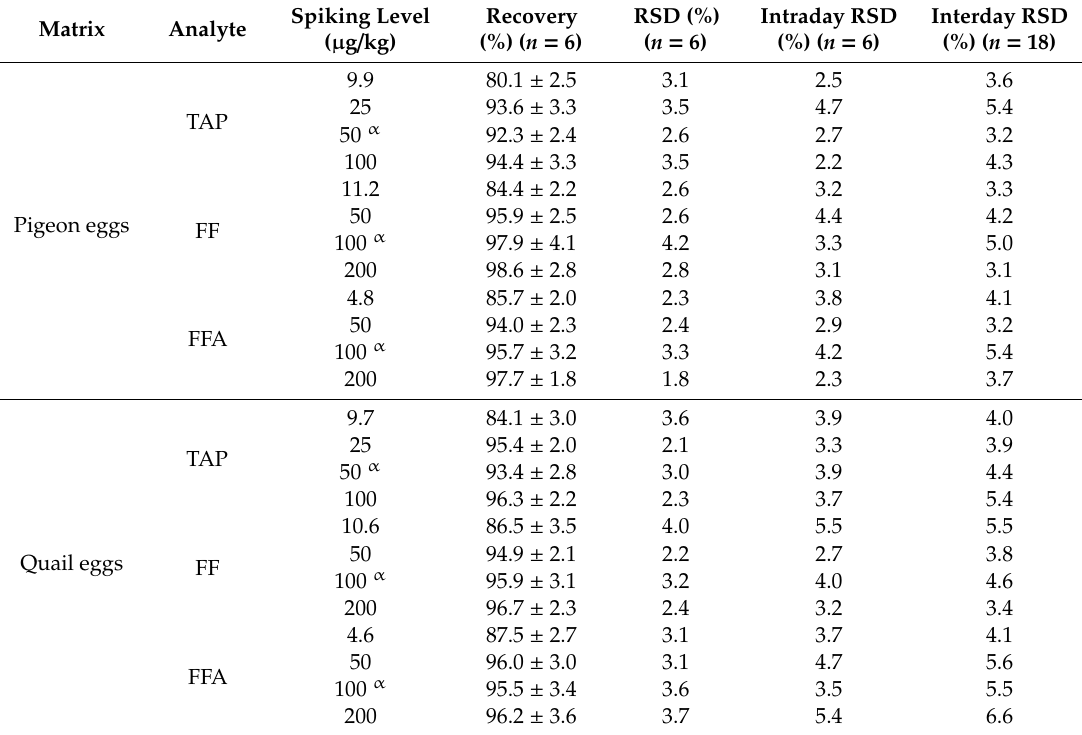
Table 5. Recoveries and precisions of TAP, FF and FFA from spiked blank pigeon eggs and quail eggs.